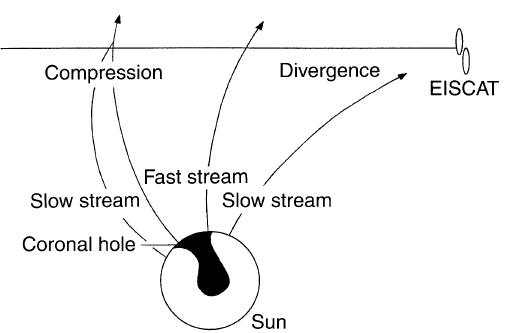
Fig. 10. a White-light map with the IPS line of sight for observations of 0603 # 219 on 11 June 1995 (a single slow stream) back-projected onto the map with an assumed constant radial velocity of 400 km s (cid:126)(cid:49) . b IPS correlation function corresponding to a , analysed using the line of sight model. The dashed line represents the data and the solid line the model fit